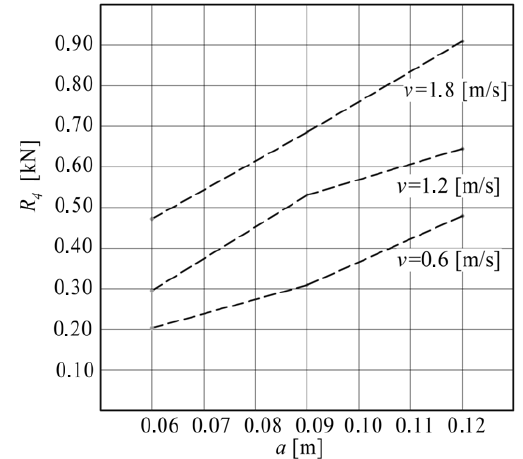
Figure 10. Determining the tractive resistance of the balancing wheel without the slotting disk (a), with the slotting disk (b)